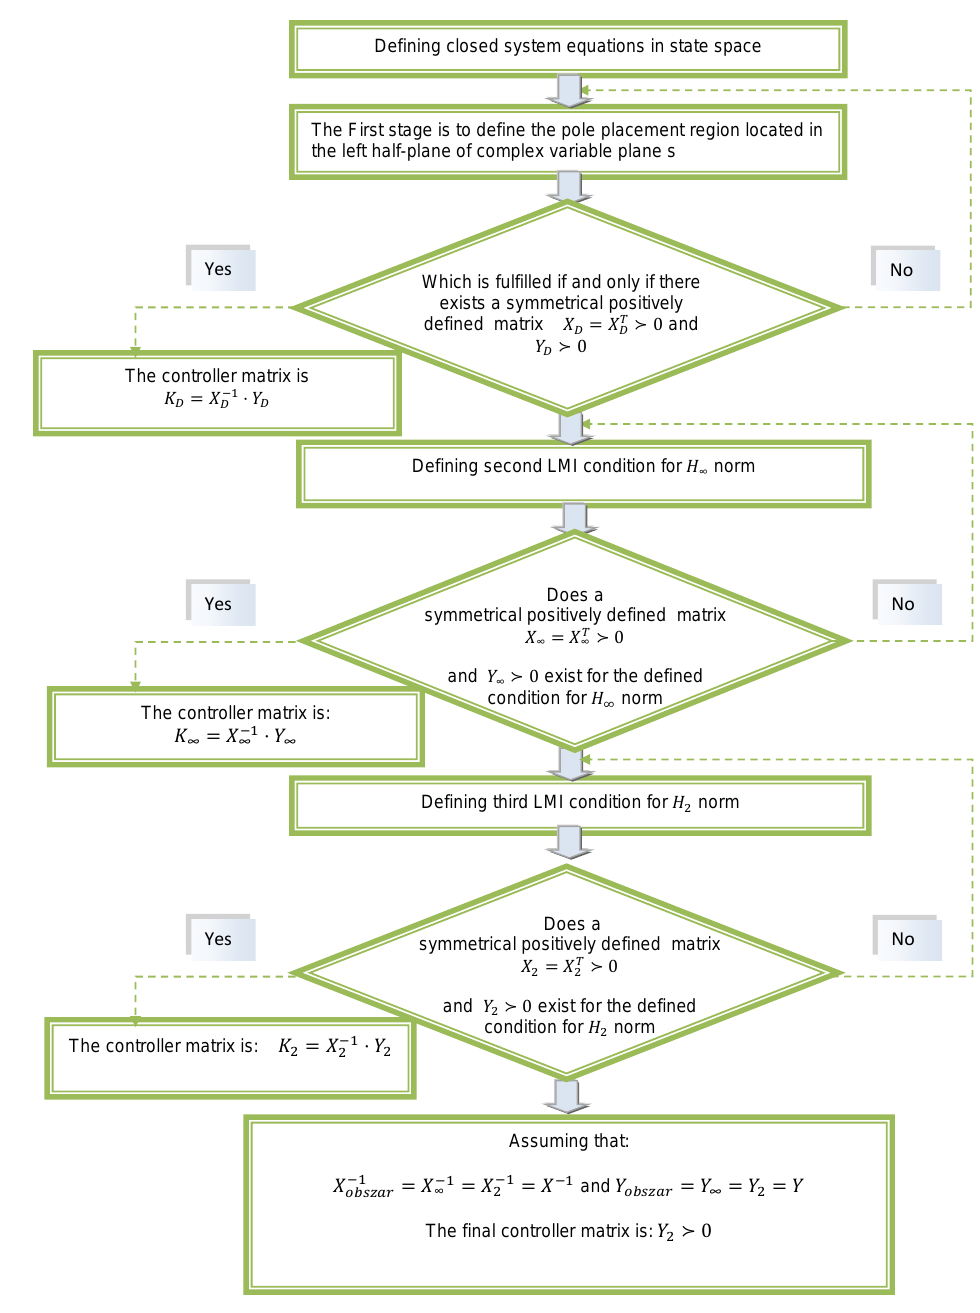
Figure 2. State controller synthesis